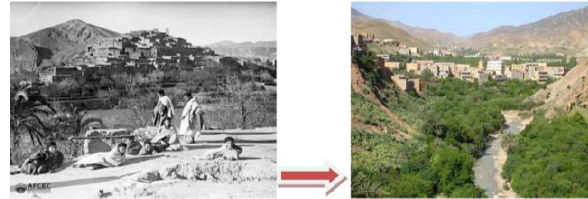
Figure 12. Example of external transformation by the use of new materials which are not local to Menaa. (Authors: Menaa between 1943 & 2016).